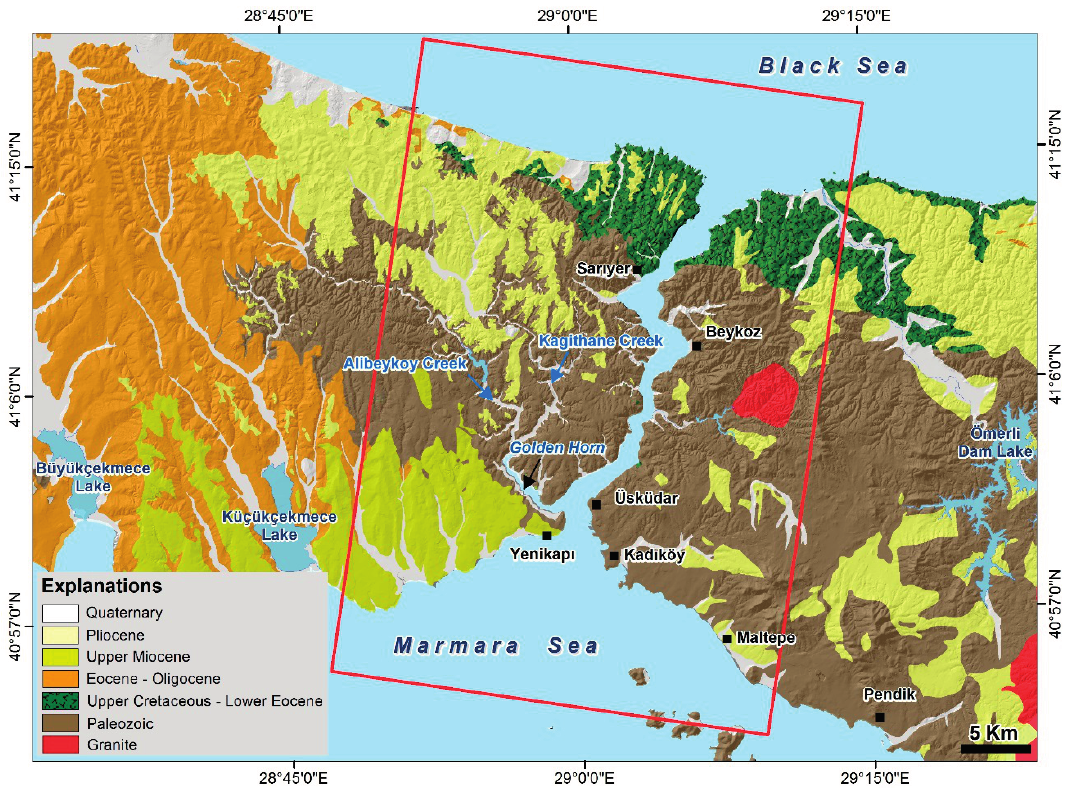
Figure 3. Geological map of Istanbul area (modified after [67]). Red frame shows the footprint of SAR data (TerraSAR-X, descending orbit) used in this